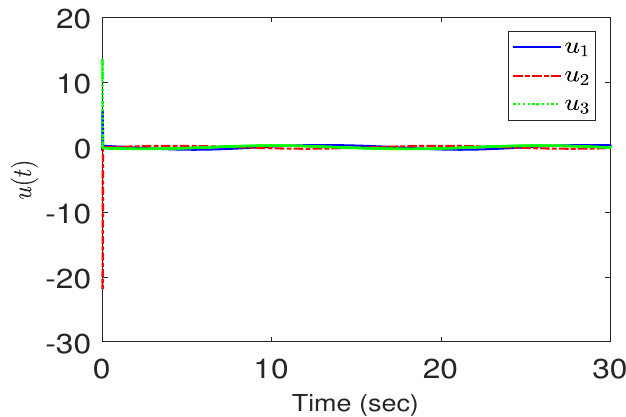
Figure 6. Control effort in Case 1.